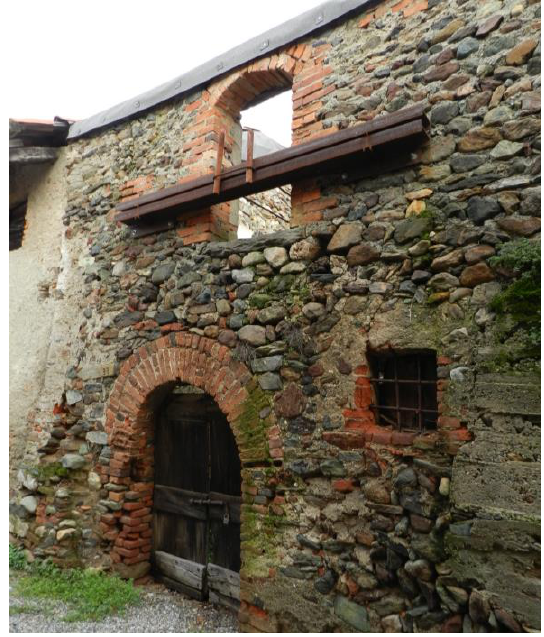
Figure 6. Building C - Temporary consolidation intervention carried out by the municipality (credits Manuela Mattone).